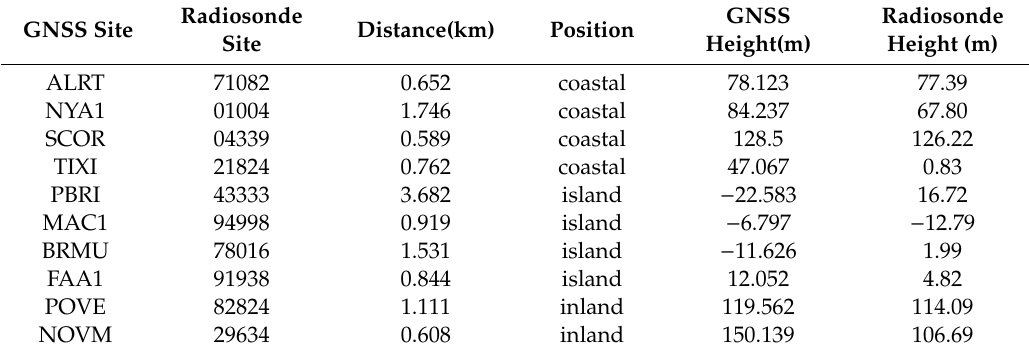
Table 1. GNSS stations and their co-located radiosonde stations.